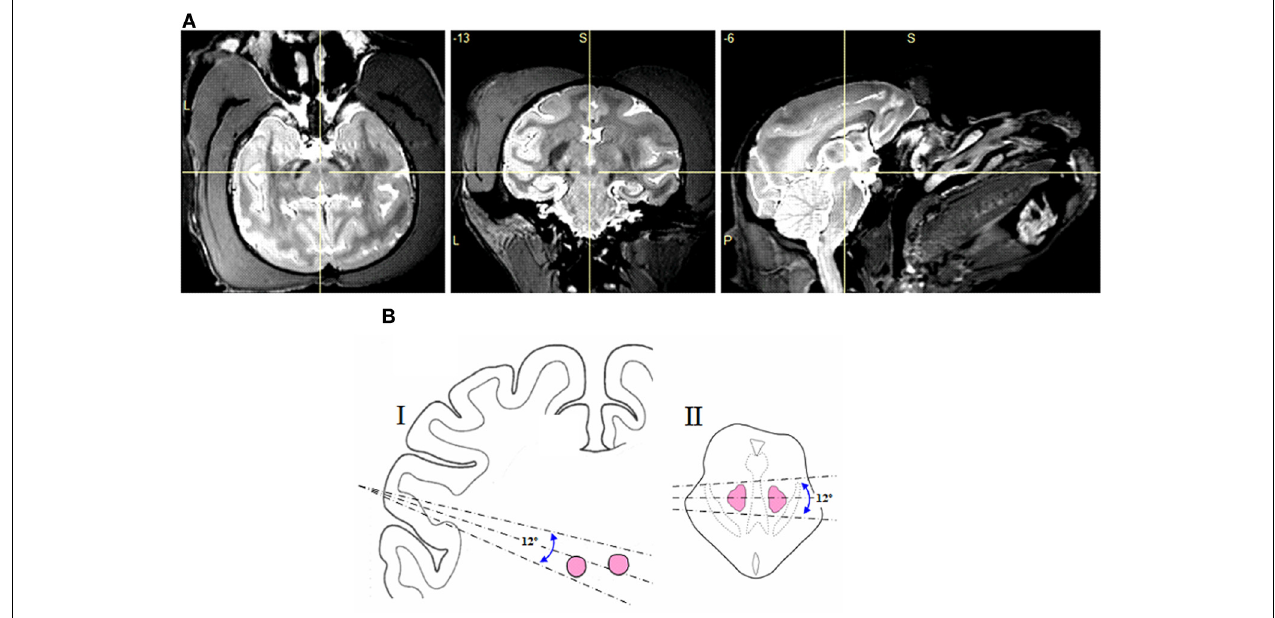
FIGURE 1 | (A) MRI images of the macaque brain (monkey E) in axial, coronal, and sagittal views, with the cross hair showing the location of the red nucleus. (B) Range of electrode angles used in the sagittal (I) and axial (II) planes.